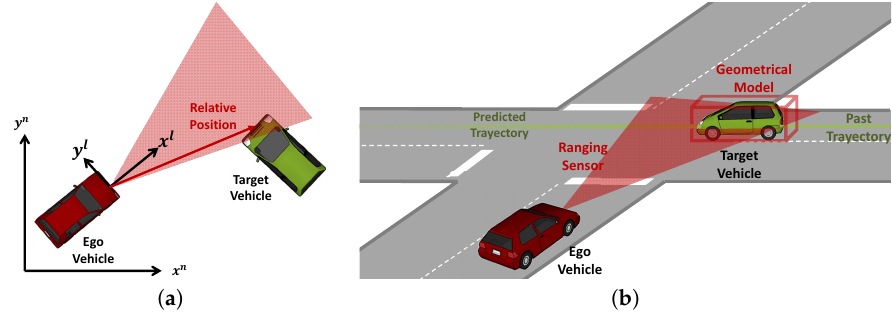
Figure 2. The figure ( a ) depicts the ego and target vehicle driving in an Earth-fixed navigation frame [ x n , y n ] . A ranging sensor in the ego vehicle is able to detect the target vehicle, whose position is given in an ego vehicle coordinate frame [ x l , y l ] . The figure ( b ) shows how a geometric model of the target vehicle can be constructed from the ranging sensor measurement data. Using a tracking algorithm, the future location of the target vehicle can be